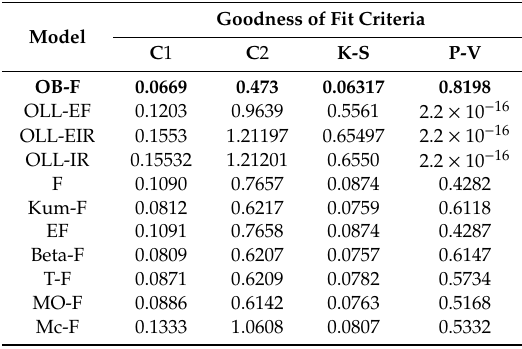
Figure 3. ( a ) Estimated density; ( b ) estimated cumulative distribution function (CDF); ( c ) P-P plot; ( d ) estimated hazard rate function (HRF) for data set I . Table 7. C1, C2, K-S and P-V for data set